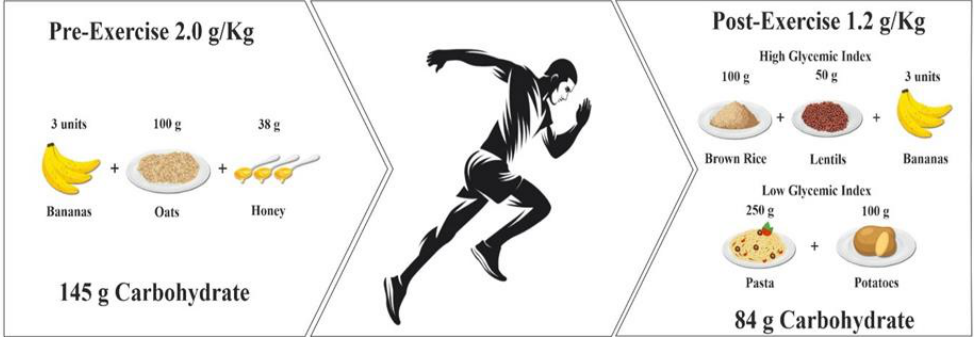
Figure 1. Examples of food-first options for pre- and post-exercise carbohydrate (CHO) provision for a 70 kg individual. Pre-exercise options can be from various CHO food sources with varying glycaemic index (GI), while post-exercise CHO provision can be high-GI . When considering pre-exercise CHO intake, many individuals will indicate foods such as potatoes, rice, and pasta as “typical” CHO sources. Potatoes are predominantly composed of water with only ~20 g of CHO per 100 g of boiled potato. Both white and brown rice consist predominantly of water (~69–70%) and contain an average of 28 g and 26 g of CHO per 100 g. White or “refined” pasta is composed of ~67% water, and 100 g of plain cooked spaghetti provides approximately 26 g of CHO. Cooked lentils are another CHO food [30] and are composed of ~19.5% CHO. All these are viable options as pre-exercise CHO meal options for athletes aiming to optimise their exercise performance, although athletes should be aware that they are relatively low in CHO per total volume, with only 20–30% comprised of CHO (Figure 2).